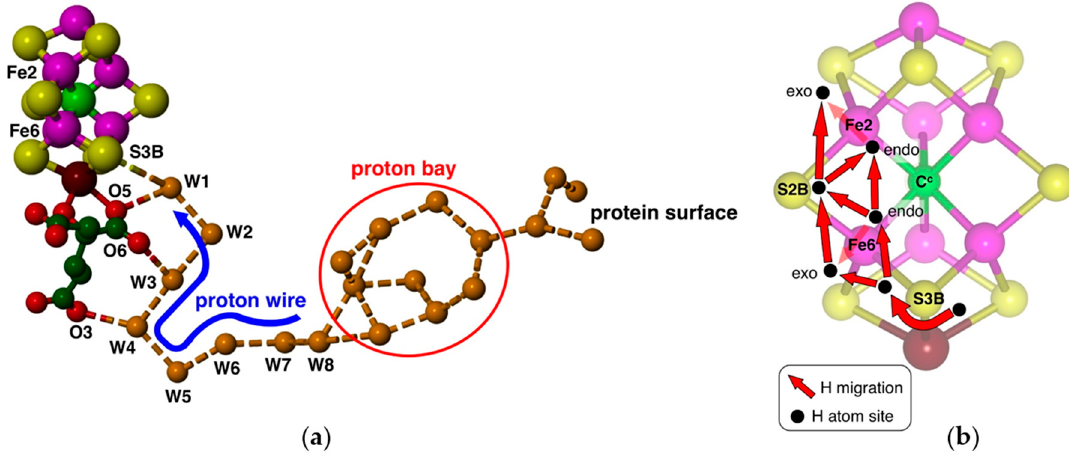
Figure 2. ( a ) The chain of water molecules (orange) extending from the protein surface to S3B of FeMo-co. Broken lines are hydrogen bonds. ( b ) The H atom (black) migration pathways (red) around S3B and then to H atom binding sites on FeMo-co.